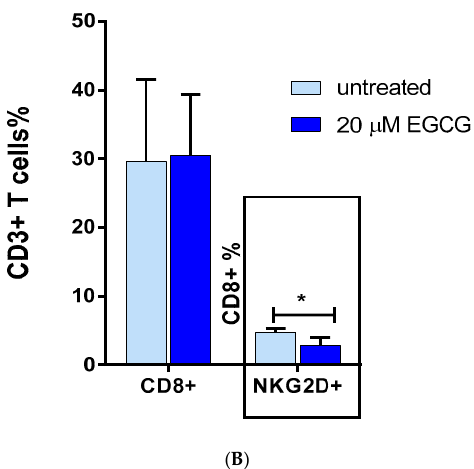
Figure 5. Treatment of AA PBMC with EGCG. ( A) Distribution of Th1 and Th17 subsets of CD4+ populations after AA PBMCs were either treated with 20 µ M EGCG or untreated and analyzed by flow cytometry using CD119 and Th17 antibodies respectively. ( B ) Distribution of CD8+ NKG2D+ populations after AA PBMC were either treated with 20 μ M EGCG or untreated and analyzed by flow cytometry using NKG2D antibody. Each experiment was repeated three times. * p < 0.05.